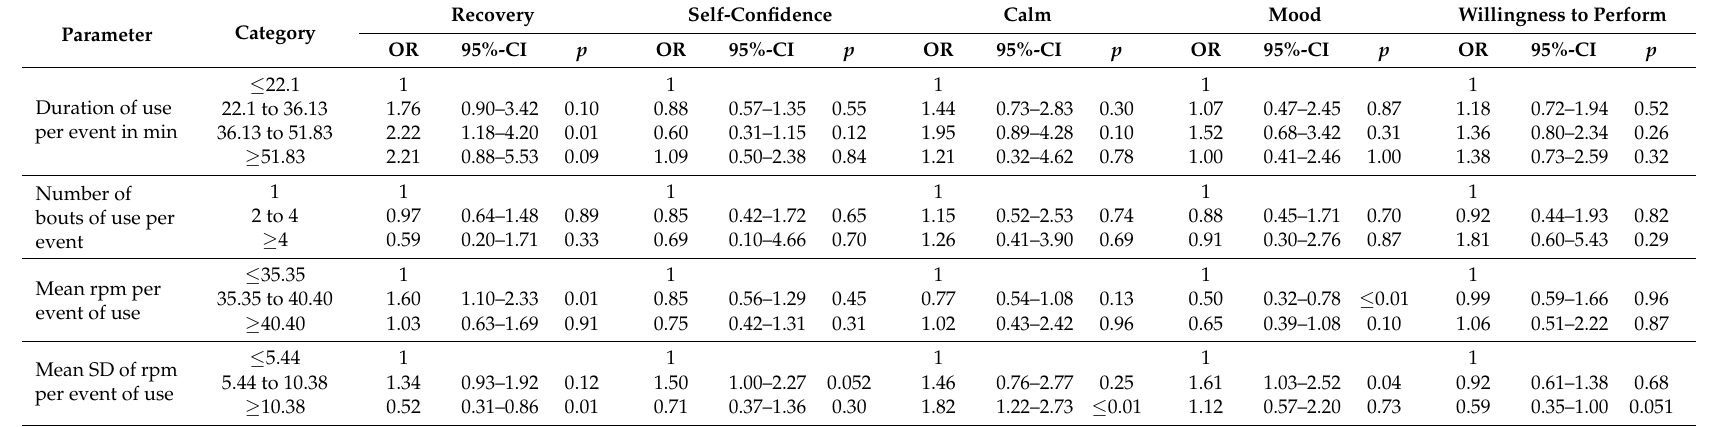
Table 5. Results of the logistic Generalized Estimating Equation (GEE) regression on changes in short-term well-being. All models are adjusted for age, gender and relative activity; OR = odds ratio; 95%-CI = 95%-confidence interval; p = p -value; significant effect when p ≤